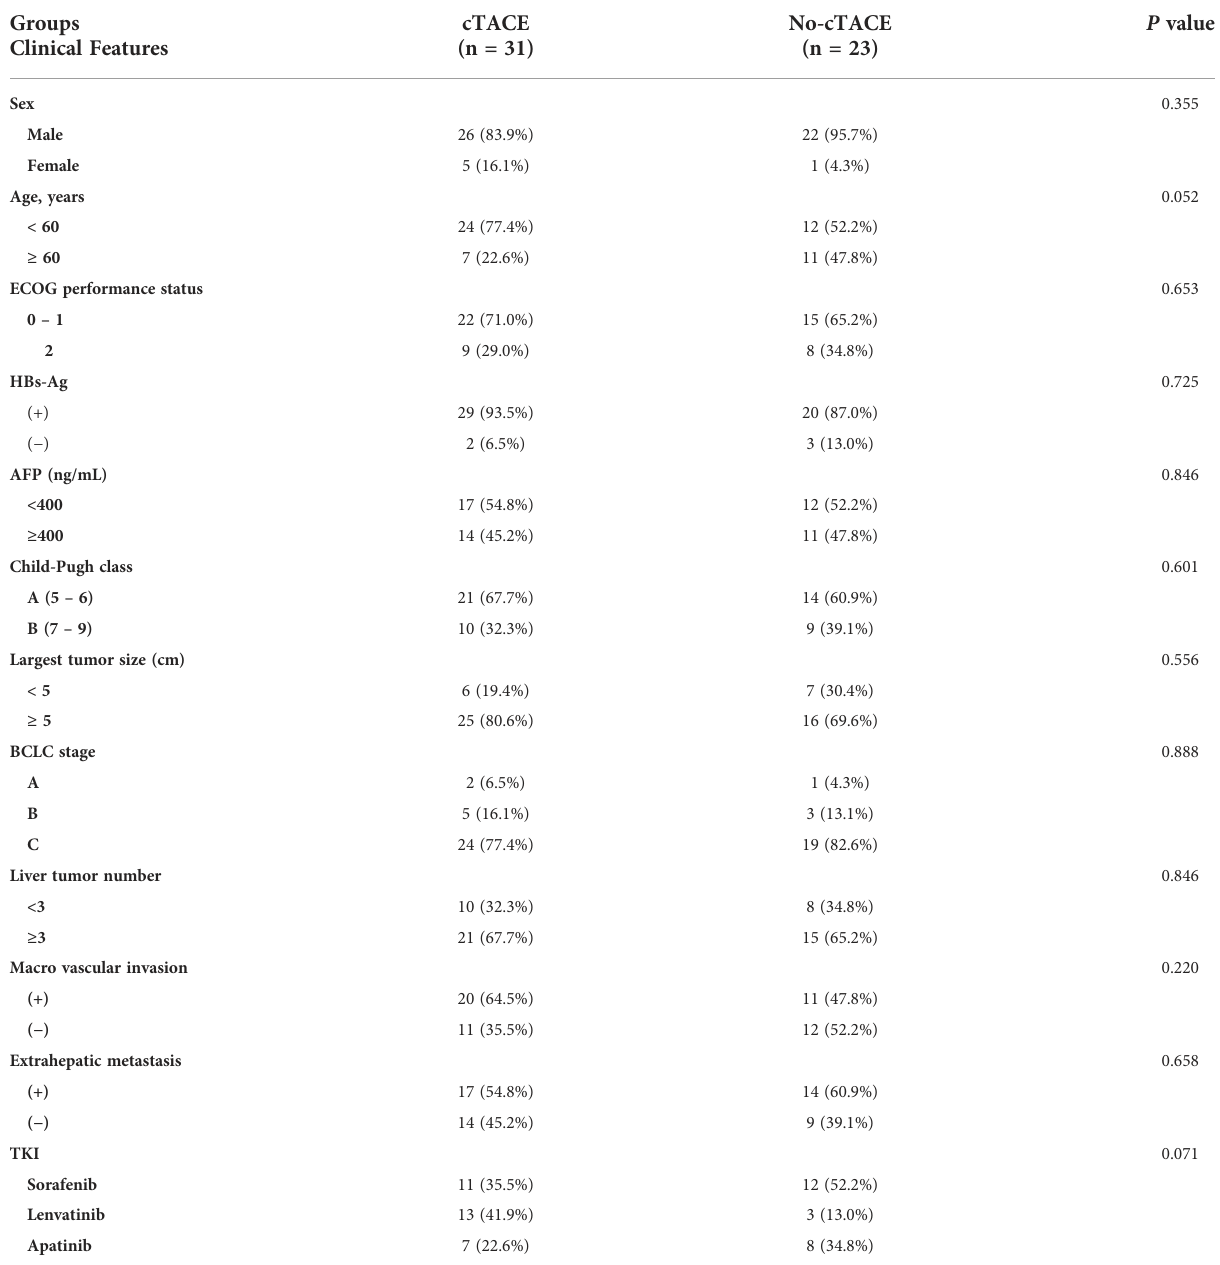
TABLE 1 Baseline characteristics of patients before treatment in both groups. Groups Clinical